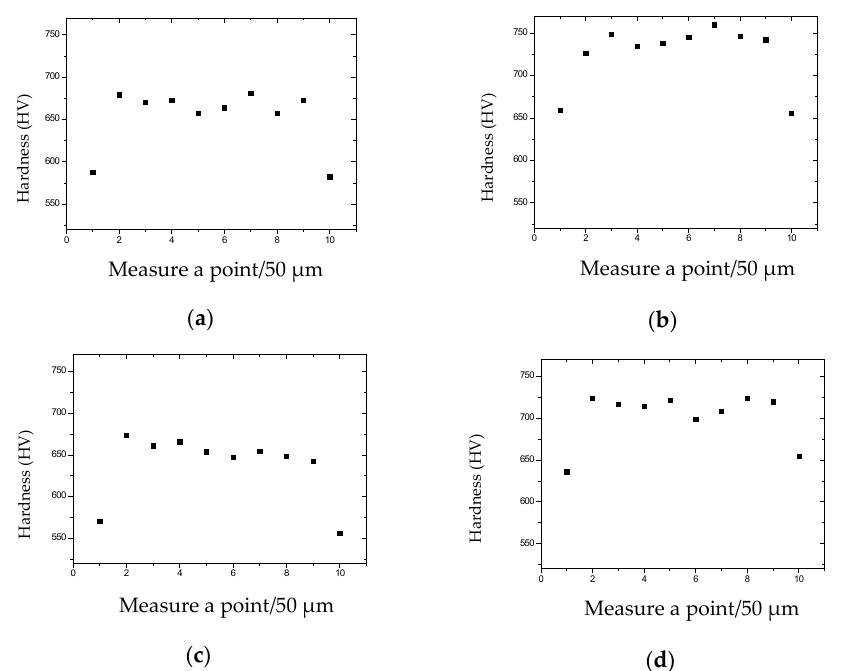
Figure 2. Microhardness data ( a ) φ0.50 mm tungsten wire prepared by Process 1, ( b ) φ0.50 mm